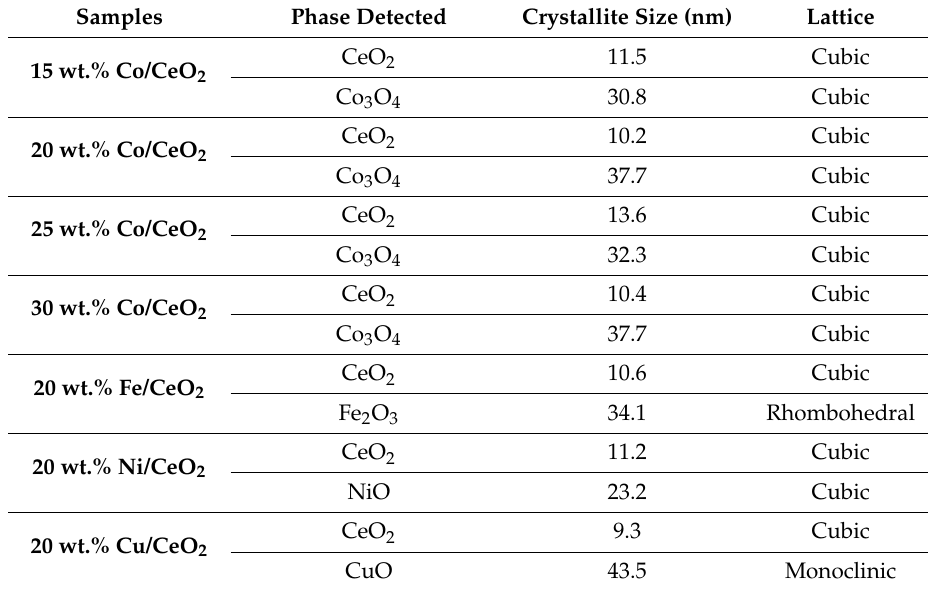
Table 2. Structural characteristics of M/CeO 2 (M: Fe, Ni, Co, Cu) catalysts. Samples Phase